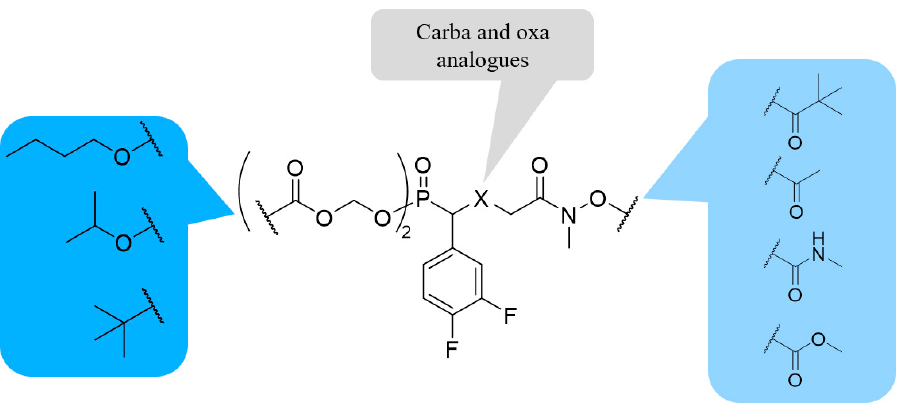
Figure 39. Schematic overview of reverse α -3,4-difluorophenyl-substituted β -oxa and carba analogs. As expected, none of the double prodrugs inhibited Pf DXR. Surprisingly, despite the nanomolar antiplasmodial in vitro activity against Pf Dd2 (IC 50 = 4–70 nM) and 3D7 (IC 50 = 8–20 nM) no significant in vivo antimalarial activity in a P. berghei and a humanized SCID P. falciparum mouse model was